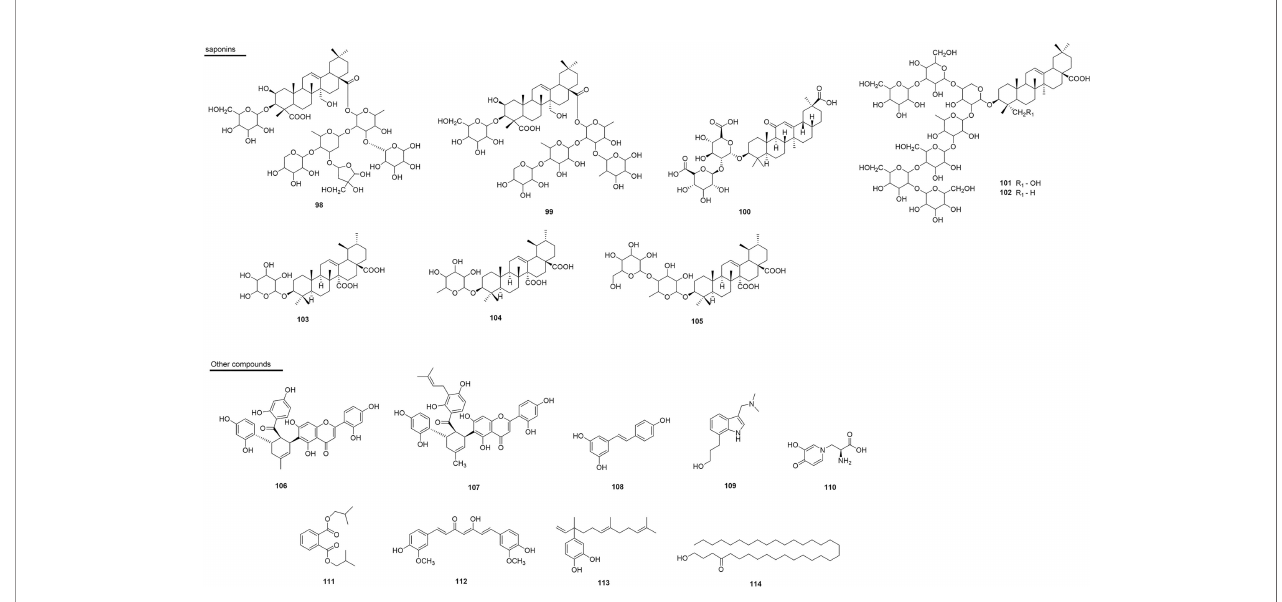
FIGURE 9 | Chemical structures of snakebite treatment compounds 98-114